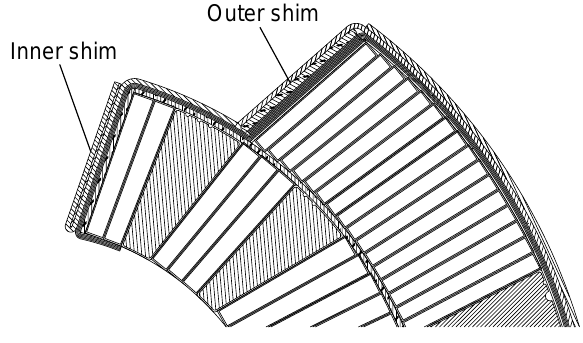
FIG. 3. Pole shims of the LHC dipole